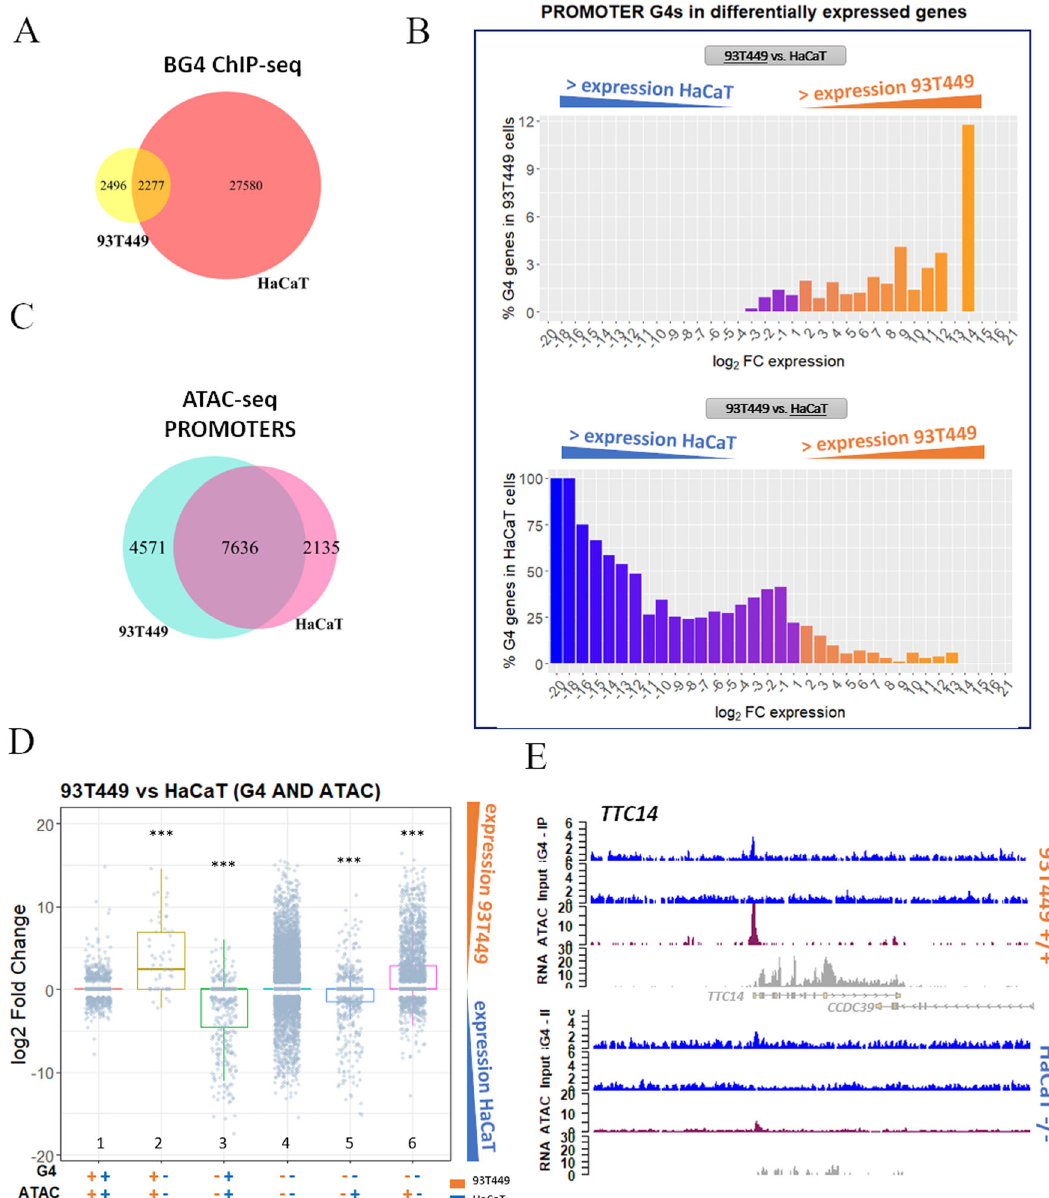
Fig. 4 Comparison of 93T449 and HaCaT cell lines. A Venn diagram showing the intersection between G4 peaks found in 93T449 (yellow) and HaCaT (salmon) cell lines. B Percentage of genes containing at least one G4 in their promoter in 93T449 (upper panel) or HaCaT (lower panel) cells, in function of their differential expression in the two cell lines expressed as log 2 fold change (FC). Orange and blue-violet bars in both panels correspond to genes that have higher expression in 93T449 cells and HaCaT cells, respectively. C Venn diagram showing the intersection between the ATAC-seq peaks found in promoters of 93T449 (light blue) and HaCaT (pink) cell lines. D Differential gene expression comparison of the same genes in 93T449 and HaCaT cells, based on the presence of G4s and open chromatin combinations. Orange and blue symbols indicate data for 93T449 and HaCaT cells, respectively. The presence ( + ) or absence ( − ) of G4s or ATAC signals are reported. Bars indicate gene expression distribution of the differentially expressed genes in 93T449 vs HaCaT cells evaluated by two-sided T test in comparison to the G4:ATAC ++ / ++ condition (CI 95%, *** p value < 0.001). Exact p values are the following: + − / + − p = 2.3e − 16, − + / − + p < 2.22e − 16, −− / − + p = 3e − 8, −− / + − p = 4e − 7. The box plots central line represents the median, the bottom, and upper bounds of the box represent the 25th and 75th percentile, respectively, and the whiskers represent the lowest and highest score, excluding outliers. G4:ATAC ++ / ++ n = 1098, + − / + − n = 61, − + / − + n = 435, −− / −− n = 14,717, −− / − + n = 649, −− / + − n = 2315. E Genomic view showing representative regions of 93T449 and HaCaT cell lines gene expression (RNA- seq track, gray) with respect to the presence of G4 peaks (ChIP-seq, blue) and open chromatin (ATAC-seq, purple). In particular, TTC14 gene is displayed, which shows both G4 and ATAC signals in 93T449 cells, while it shows limited accessibility and no G4 in HaCaT cells. These differences are re fl ected in the corresponding RNA amount, which is much lower in HaCaT cells. Source data for each panel are provided or referenced in the Source data fi